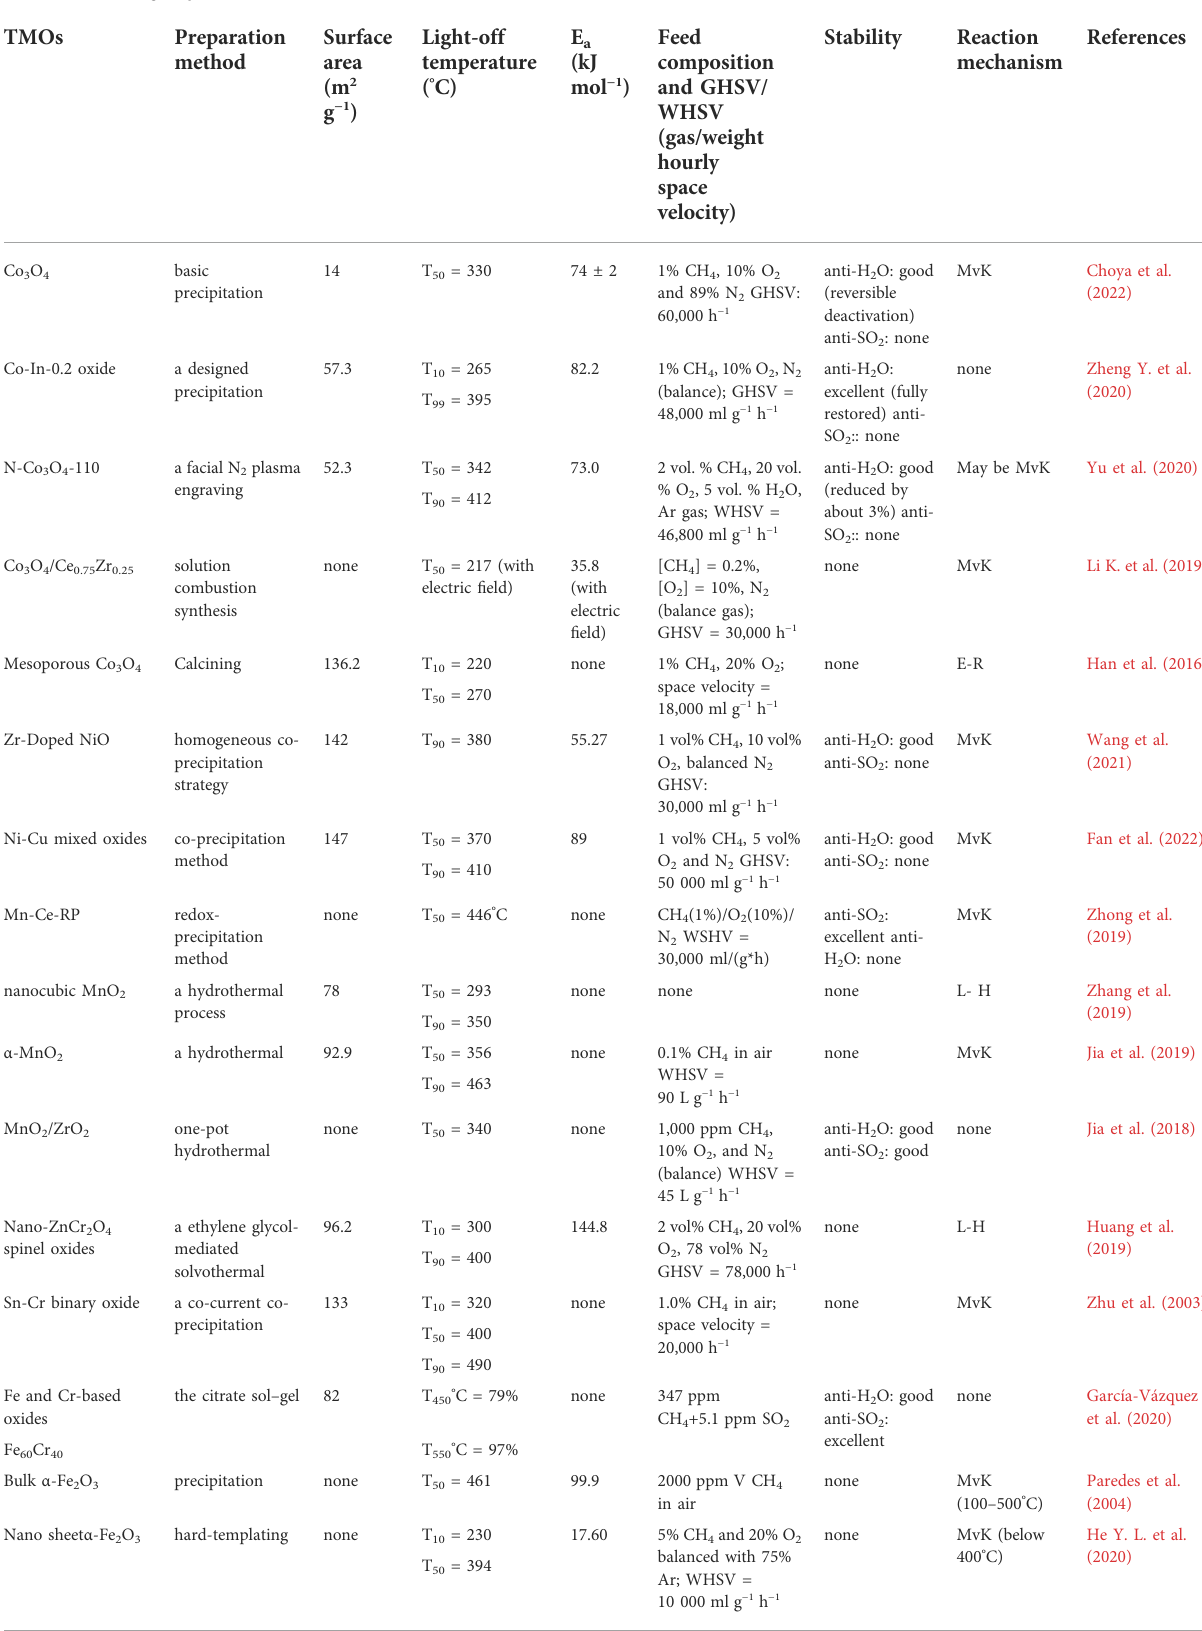
TABLE 1 The catalytic performances of different TMOs for